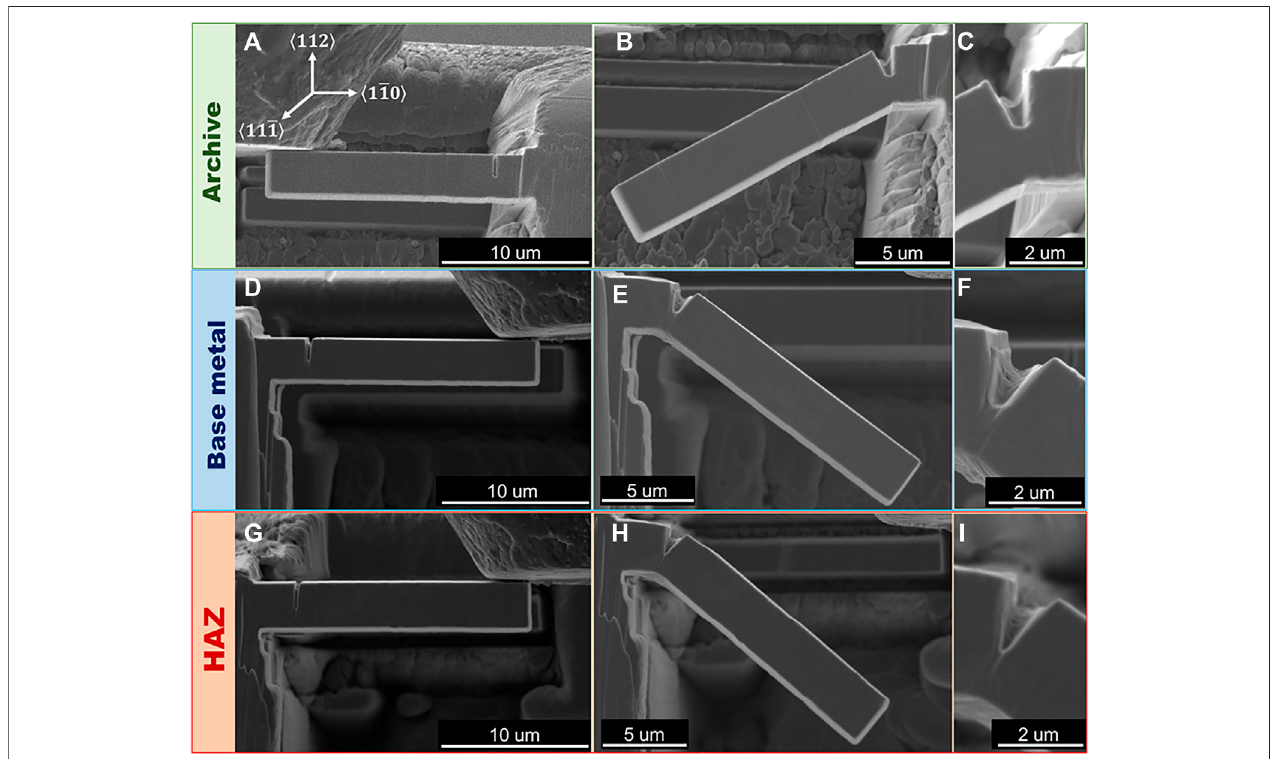
FIGURE 3 | Load versus displacement curves for the microcantilevers in the (A) archive specimen, and (B) base metal and (C) HAZ region of the irradiated specimen. The legend indicates the bending direction of each cantilever.